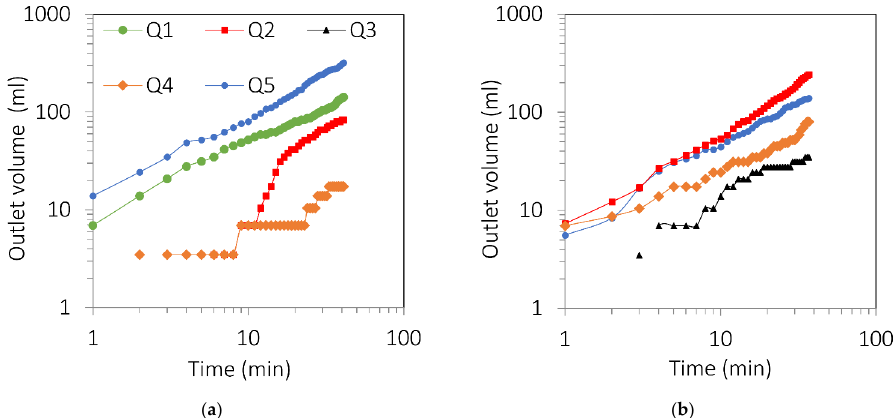
Figure 5. Outlet volume (mL) vs. time (min) at different test sections for ( a ) Fracture ‐ 2 with a fracture inclination of 45°; ( b ) Fracture ‐ 4 with a fracture inclination of 45°. The distribution of flow rates over the outlet sections is more sensitive to the change in fractal dimension than the fracture inclination angle. This can be justified by the fact that the fractal dimension, as a representative parameter of fracture aperture geometric distribution, changed preferential flow paths significantly, whereas the variation of incli ‐ nation angle changed the values of the discharge rates. The effect of mismatch length on the outlet volume can be analyzed by comparing Fracture ‐ 1 (Figure 4a) and Fracture ‐ 4 (Figure 5b) with the same inclination angle (45°) and fractal dimension ( 𝐷 (cid:3021) (cid:3404) 2.2 (cid:4667) and different mismatch length values. According to Figures 4a and 5b, section Q2 presents the maximum flow rates for each of two different mismatch lengths. In addition, the mean value of Q2 decreased by about 12%. A similar trend could be observed for all outlet sections except Q4. This was confirmed by the fact that a reduc ‐ tion in mismatch length led to the decrease in mean aperture and corresponding fracture equivalent permeability, whereas the preferential channel locations remain constant. The results of the flow rate distribution through the five sections confirm the findings of Li et al. [15], who carried out investigations of flow paths in concrete self ‐ affine frac ‐ tures. Figure 6 shows a comparison of the maximum discharge rates (Q2 and Q3) between two samples of Fracture ‐ 1. Though there is a high correlation (R > 0.9) between the two samples, the expected error is high (RMSE = 38.65), especially at high discharge rates. It is clear from Figure 6 that the epoxy resin samples tend to underestimate maximum dis ‐ charge rates. The viscosity of epoxy resin is lower than the viscosity of concrete, and hence, the surface is more consistent with plastic mold geometry. Additionally, according to the difference in properties of resin and concrete, the sur ‐ face tension and corresponding capillary forces are different. 3.2. Preferential Flow Paths in Dry Fractures In this section, the flow movement of four inclined single fractures was traced and analyzed. The image of the first finger in the unsaturated Fracture ‐ 1 for 𝛽 (cid:3404) 45° is shown in Figure 7. As seen in the figure, water first starts to distribute near the inlets, and then (after 4 s), a capillary zone forms and the first flow path is created. The first channel in Figure 7 includes five capillary zones and several small intermediate channels. The travel time and